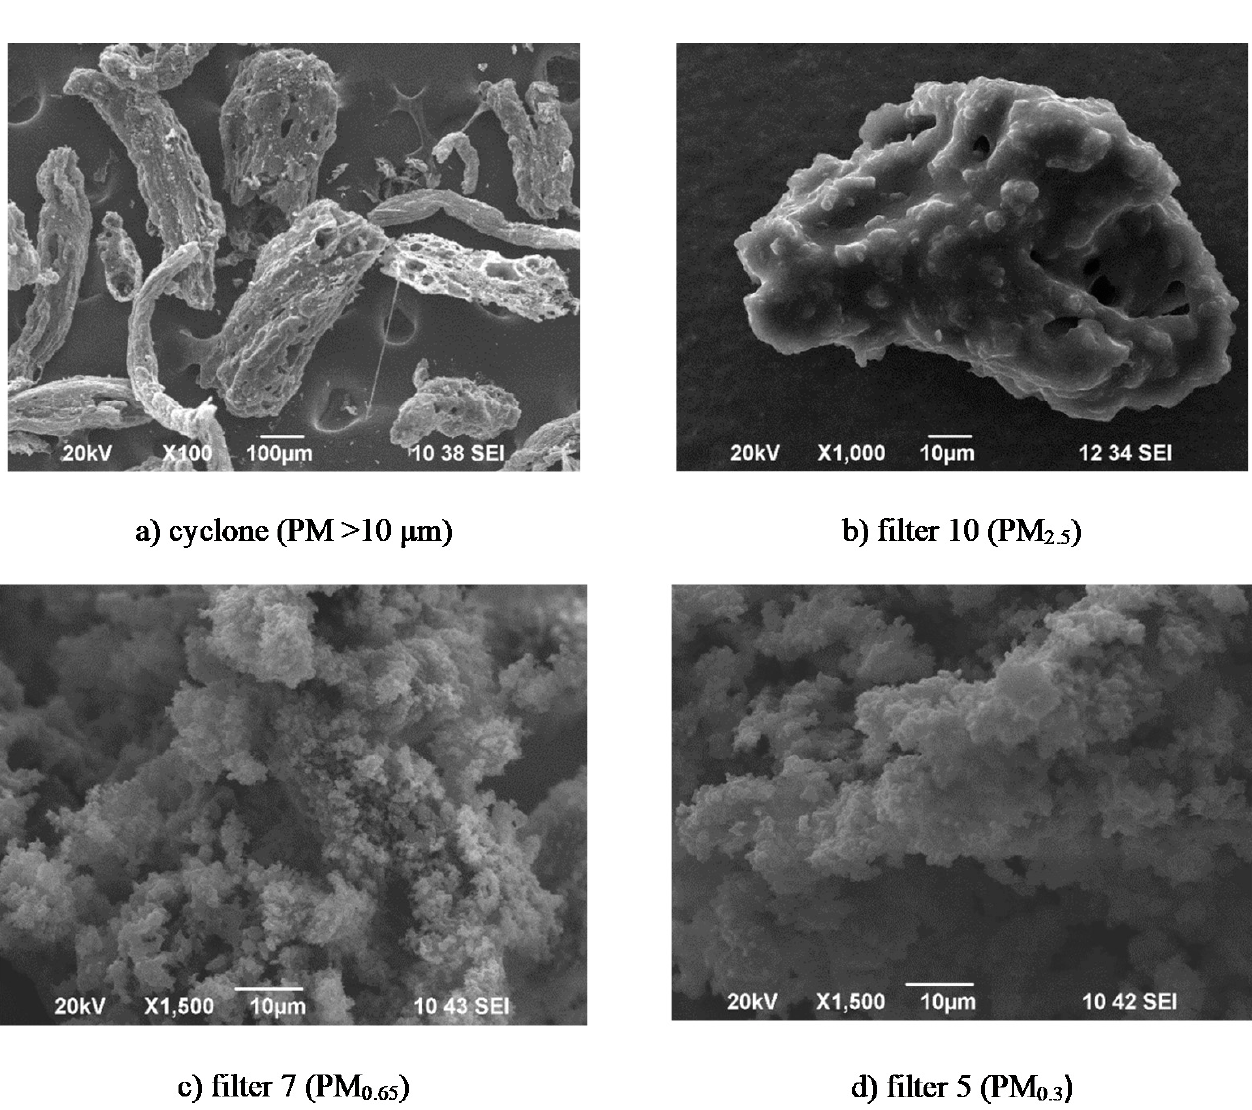
Figure 7. SEM images of rapeseed PM, sampled from different filters. Table 3. Elemental composition of particulate matter, obtained through the EDS analysis.